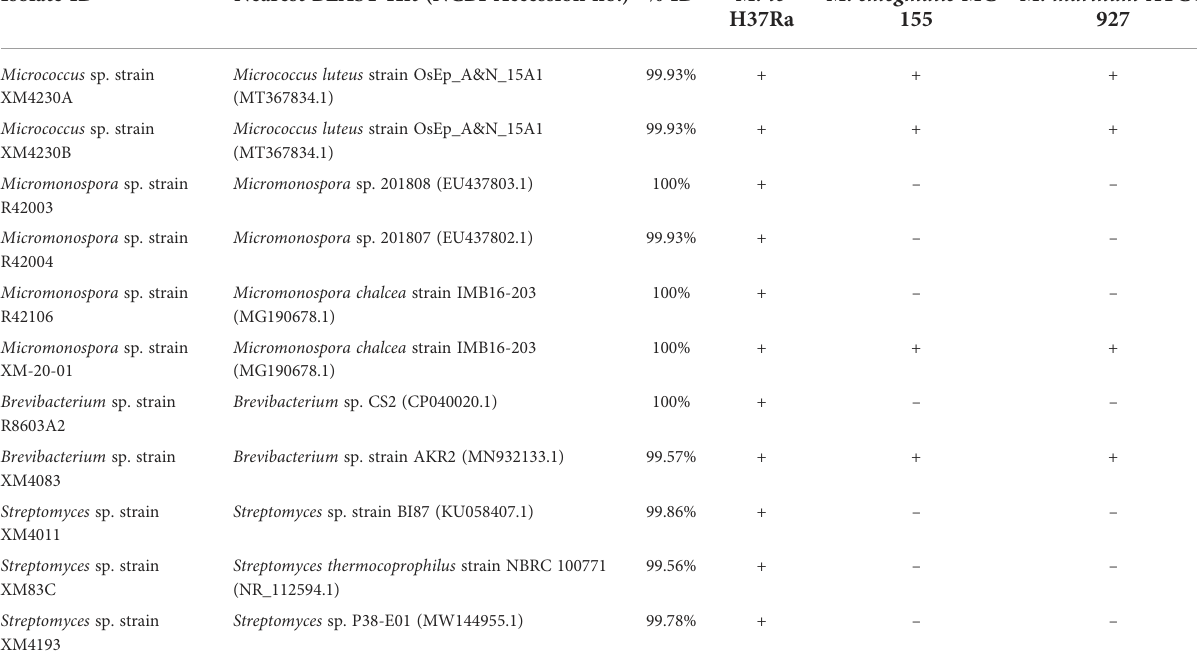
TABLE 1 Strain identi fi cation of active extracts, nearest well-identi fi ed BLAST hit and observed bioactivity. Isolate ID Nearest BLAST Hit (NCBI Accession no.) % ID